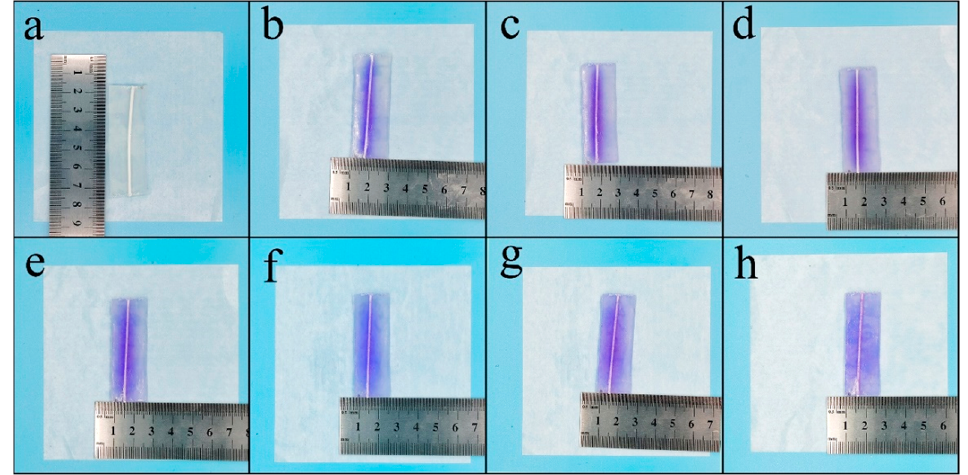
Figure 4. Photographs of the self-healing process with the agent diffusion process. ( a – d ) The healing agent spread to both sides with the fibers as the axis, and ( e – h ) the healing agent had spread throughout the gel by day